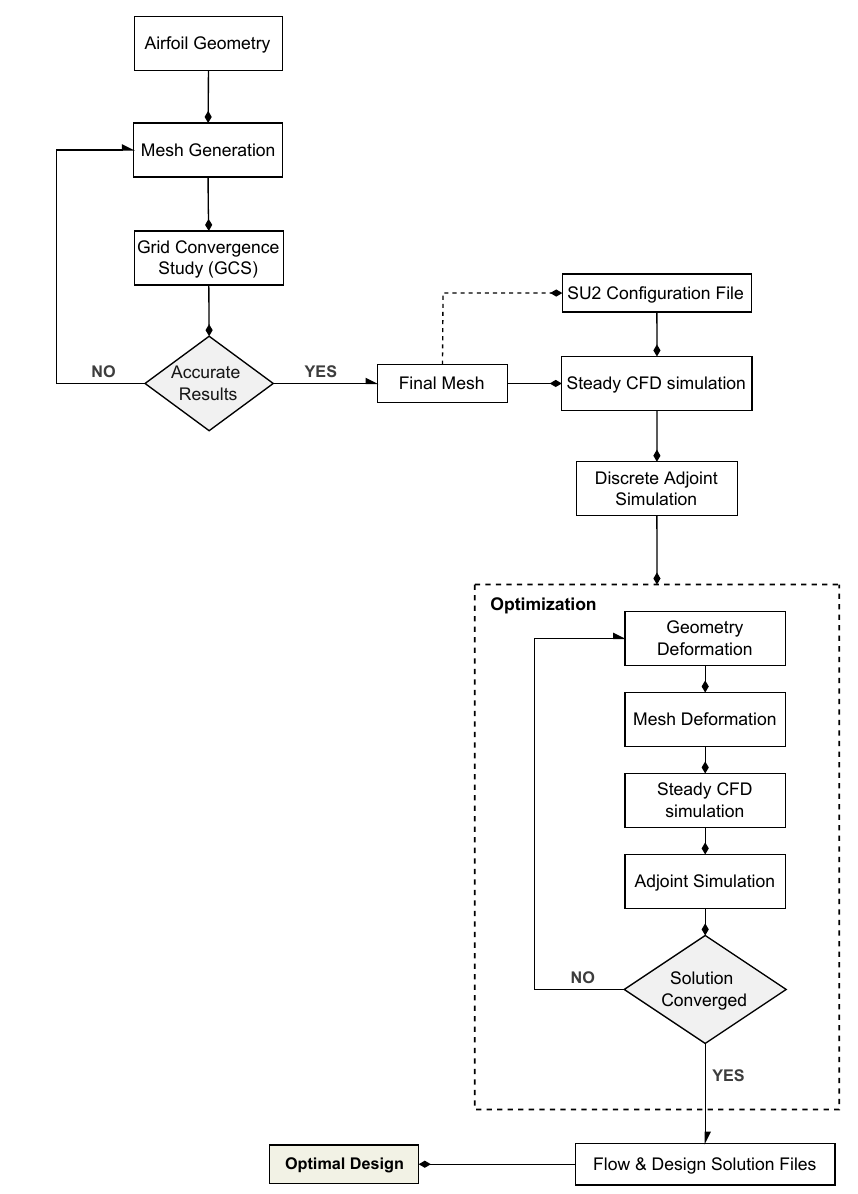
Figure 7. Gradient-based optimization